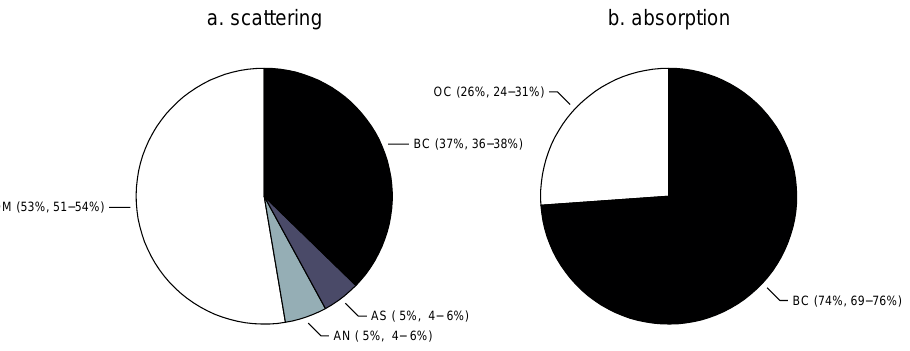
Fig. 5. Apportionment of (a) scattering and (b) absorption at a wavelength of 550nm in tropical southern Africa. Shown are the median percent contributions (with the interquartile range) of organic matter (OM), black carbon (BC), ammonium nitrate (AN), and ammonium sulfate (AS).